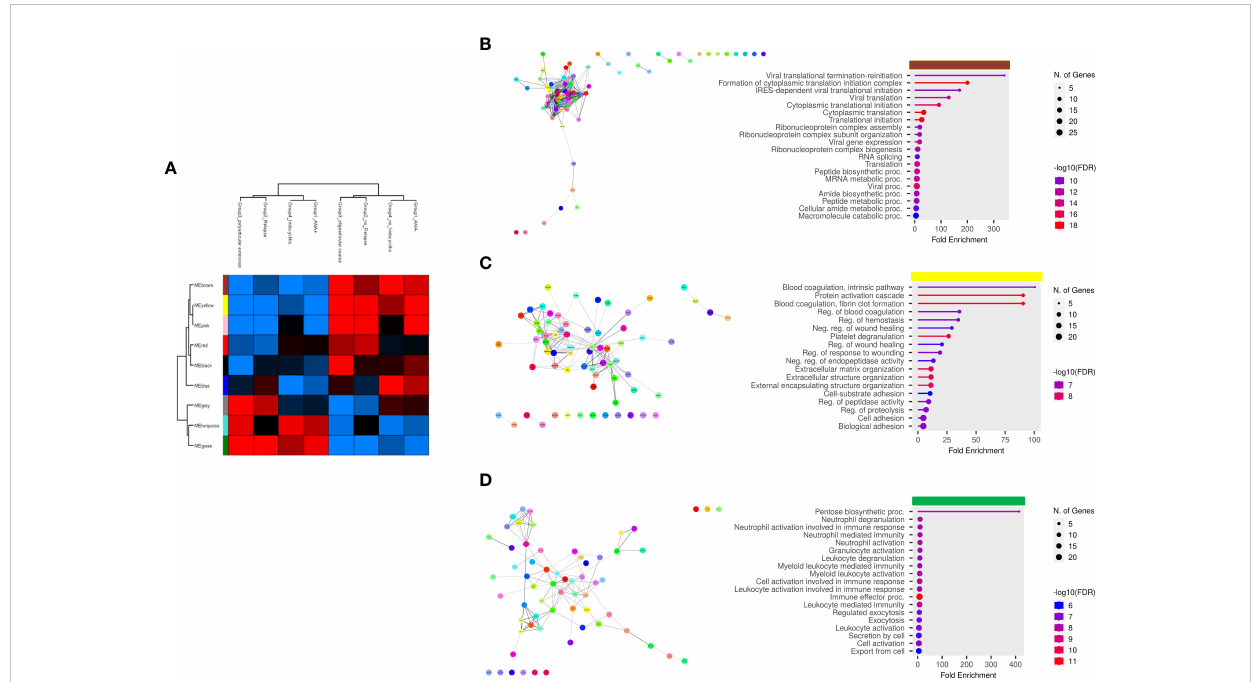
FIGURE 7 Weighted correlation co-expression network analysis of EV-prot datasets in SF_OJIA samples. WGCNA was carried out on the 30 SF_OJIA samples with a speci fi c software R package in the Perseus platform to construct co-expression modules functionally associated with four selected patient clinical and laboratory parameters. Proteins were grouped based on the correlation of their expression with the clinical parameters used. (A) Heat map representation shows the weighted relationship between nine protein modules and the four patient clinical parameters. Each row represents a module and each column a clinical group. Each module is represented by a speci fi c color. Modules are distinguished by different colors. The color scale shows module-clinical groups Pearson correlation, with red for positive correlation, blue for negative correlation, and black for equal correlation. The hierarchical cluster dendrogram is displayed at the top of the plot. (B – D) Functional interaction networks and GO biological process enrichment analyses were carried out on selected EV-prot modules. as detailed in the legend of Figures 3C, D. Selected modules are indicated by the horizontal colored bars on top of the graphs showing the most relevant enriched GO